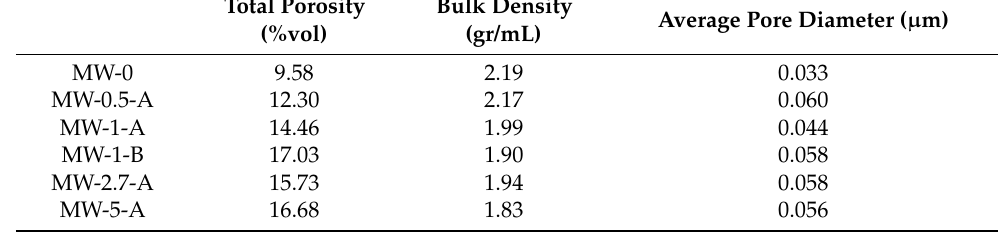
Table 2. Microstructure characteristics of samples.